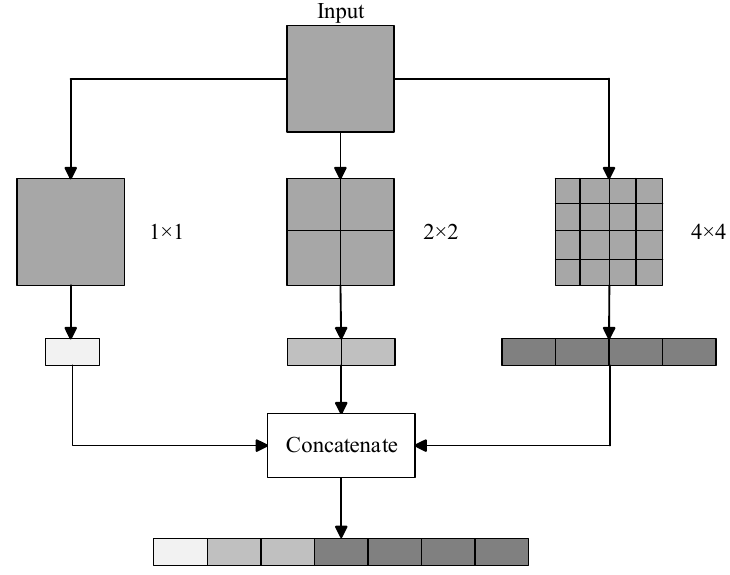
Figure 4. Spatial pyramid pooling (SPP) operation.